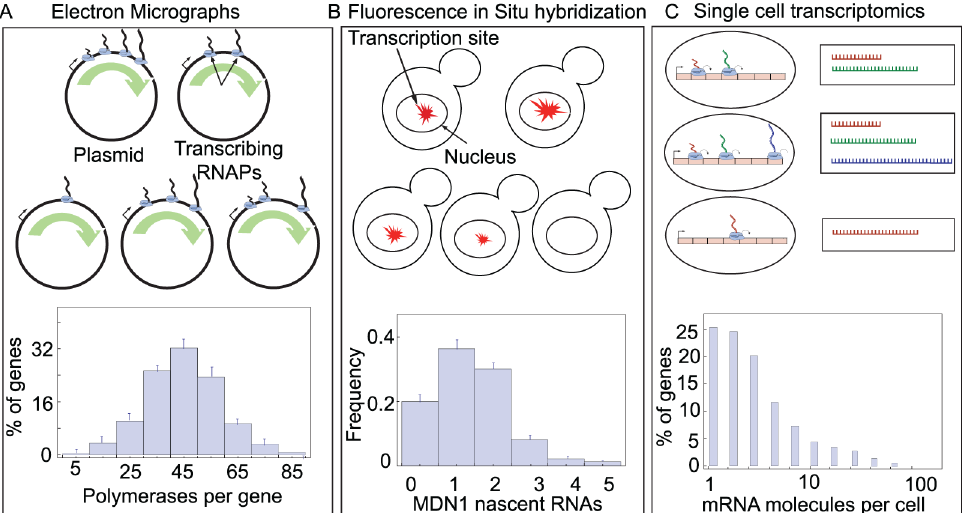
Fig 1. Experimental methods to count nascent RNA (transcribing RNA polymerase molecules). (A) Electron micrographs of intact chromosomes extracted from cells provide images of transcribing polymerases along a gene (also referred to as Miller spreads). This method allows one to count the number of RNAP molecules that are actively transcribing a gene of interest across a population of genetically identical cells. Histograms for the distribution of number of Pol I molecules is shown along rDNA, for a wild type yeast cell (adapted from [67]). (B) Fluorescence in Situ Hybridization (FISH) in single cells provide the intensity of the transcription site, which can then be used to count the number of nascent RNAs for a particular gene. Histogram for the nascent RNA distribution is shown for MDN1 gene in yeast (adapted from [25]) (C) Such measurements can be used to count the number of nascent RNA transcripts using the fact that the length of nascent RNA transcripts are shorter than the mRNA transcripts. Histograms for mRNA distribution [68] in ES cells is shown.